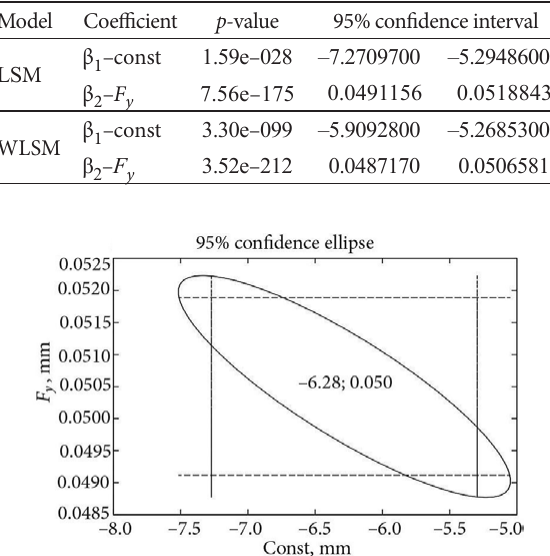
Fig. 7. Confidence ellipse of regression coefficients for the LSM